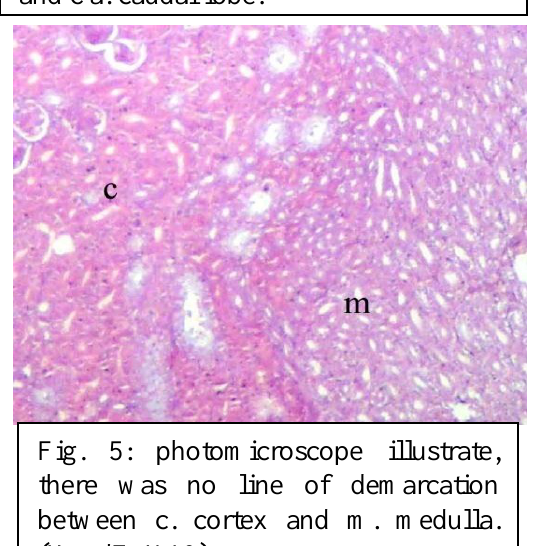
Fig. 5: photomicroscope illustrate, there was no line of demarcation between c. cortex and m. medulla. (HandE, X10)